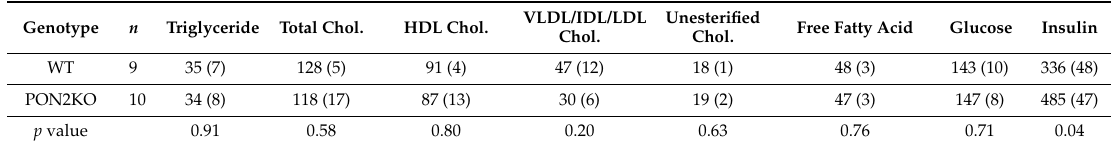
Values shown are means and (standard errors). Units are mg/dL except insulin which is shown in pg/mL. Abbreviations: Chol.: cholesterol, VLDL/IDL/LDL: very low density lipoprotein/intermediate density lipoprotein/low density